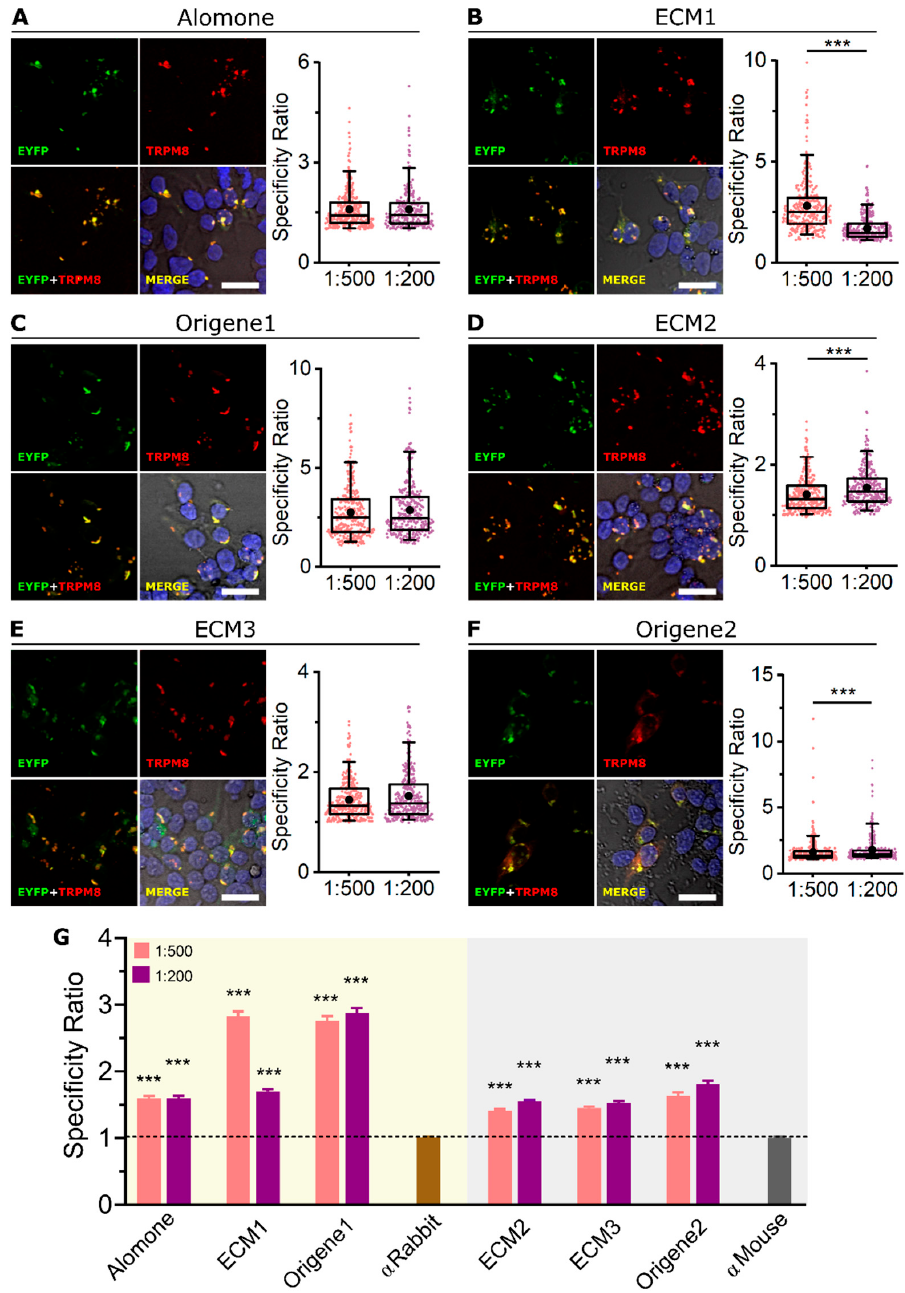
Figure 2. Immunocytochemistry of mTRPM8 in transfected HEK-293 cells. ( A – F left) Confocal images of mTRPM8-EYFP transiently expressed in HEK-293 cells. EYFP (green), TRPM8 antibody (red) and Hoechst staining (blue). Merge images correspond to the overlap of the three fluorescent signals plus the bright field image. Scale bar: 30 µm. ( A – F right) Box plots represent the specificity ratio (SR) for each dilution of the respective antibody. Each dot corresponds to an individual EYFP+ cell. Box contains the 25th to 75th percentiles. Whiskers mark the 5th and 95th percentiles. The line inside the box denotes the median and the black dot represents the mean. (*** p < 0.001, Mann–Whitney test). ( G ) Bar histogram summarizing the SR mean ± SEM of each TRPM8 antibody and the controls without primary antibody ( α Rabbit or α Mouse secondary antibodies alone). Dashed line indicates SR = 1. (*** p < 0.001, Kruskal–Wallis followed by Dunn’s post hoc test vs. α Rabbit or α Mouse). For each antibody and dilution, n > 270 cells; 4 fields from 2 independent transfections.